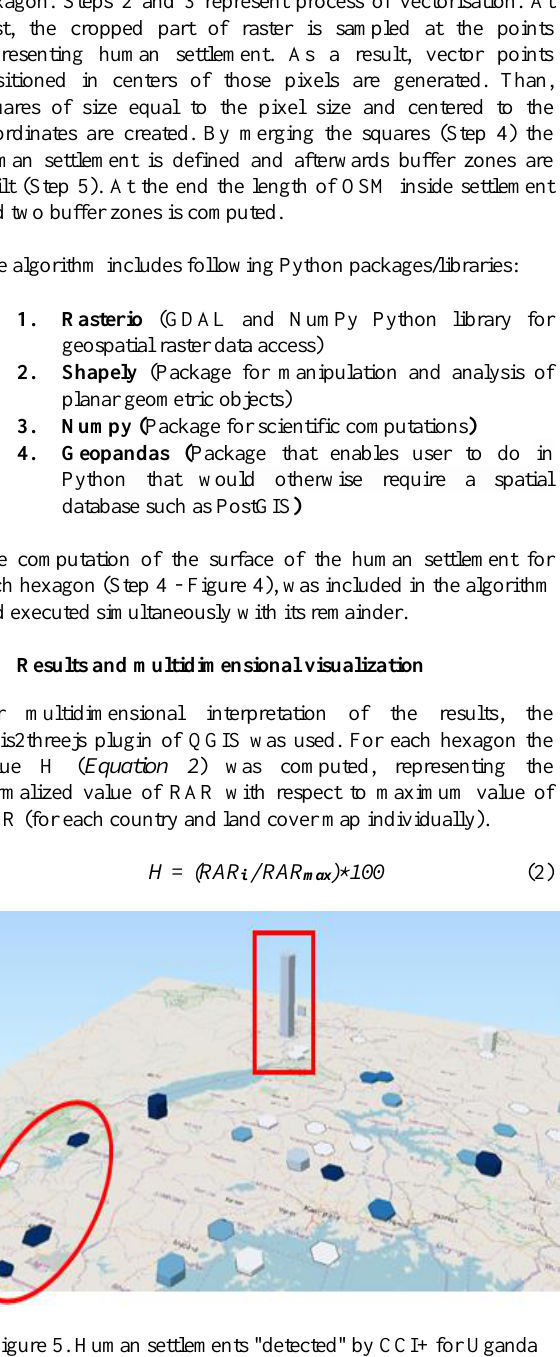
Figure 5. Human settlements "detected" by CCI+ for Uganda Looking at Figure 5, one can notice different shades of blue. They are depicting different density of population per square kilometer. The darker the color is, the greater is the density. The height of hexagons is defined by normalized RAR value (H). Its value goes from 0 to 100. The hexagon in red rectangle ( Figure 5 ) is showing the greatest value of H. It means that the accessibility of roads within 2 kilometers around a human settlement ‘detected’ within CCI+ is good. It might happen that the detection of settlement using CCI+ is wrong, but in this particular case, computation of parameter H based on GL30 and GHS gave the same result [H=100] (check red rectangles on Figures 6 and 7).